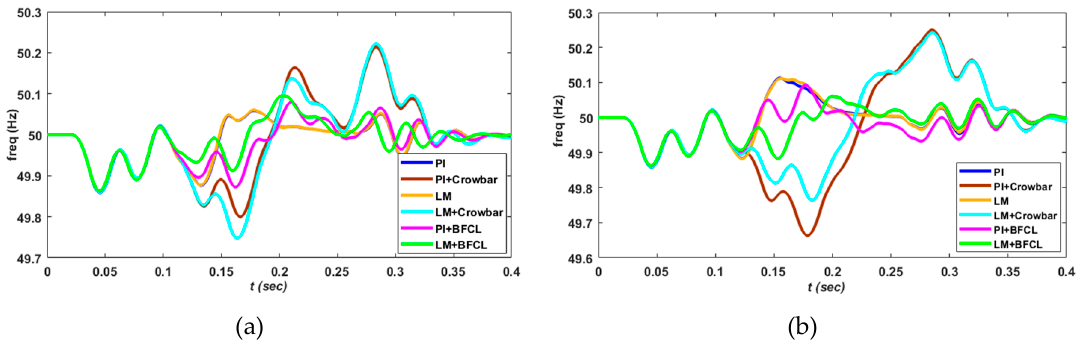
Figure 24. Frequency behavior during the P-G fault ( a ) and the P-P fault ( b ) at 5-km distance from PCC.